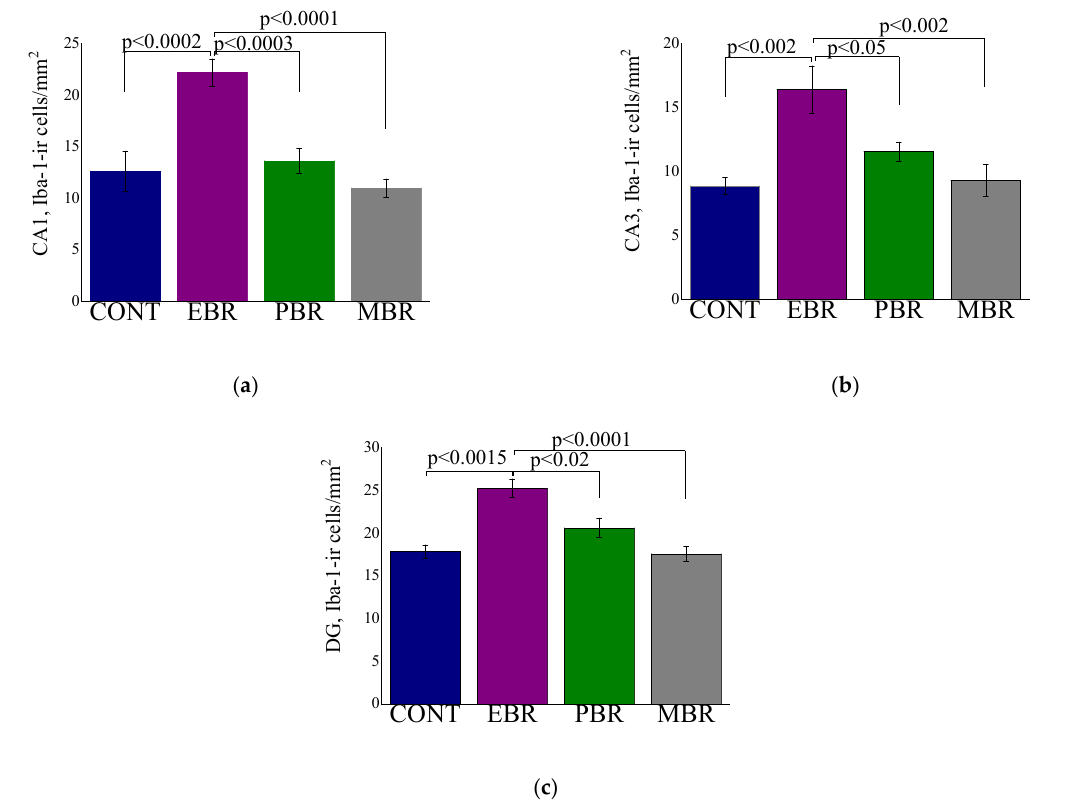
Figure 4. The quantitative morphometric analysis of Iba-1 immunoreactivity (ir) in cells of the hip- pocampal subregions CA1 ( a ), CA3 ( b ), and DG ( c ) in unexposed controls (CONT) in animals with an extreme behavioral response (EBR) or partial response (PBR) to the PSS exposure, and in animals whose behavior was minimally affected by the stressor (MBR). All data represent the group means ± S.E.M.